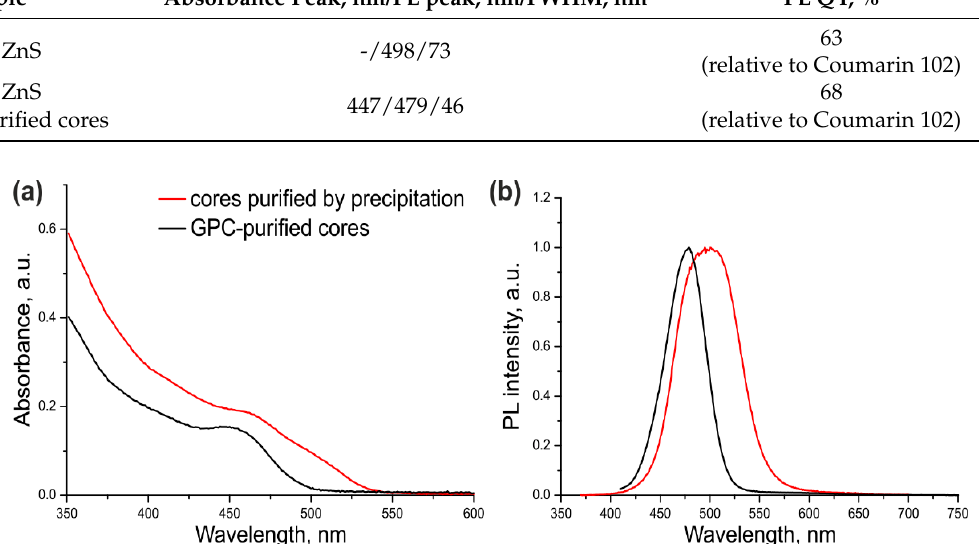
Figure 2. The absorption ( a ) and fluorescence ( b ) spectra of the CdSe/ZnS QDs purified by GPC. The black curves correspond to QDs with GPC-purified cores; the red curves correspond to QDs with cores purified by the common precipitation/redispersion technique.